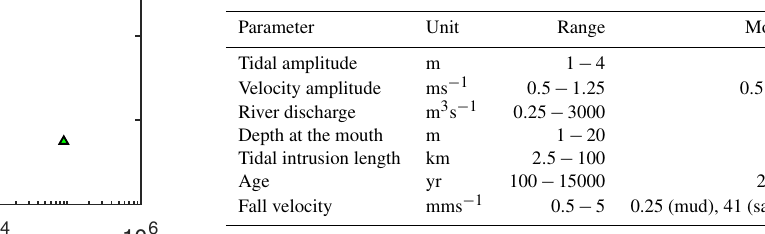
Table 4. Ranges of conditions in mixed estuaries at temperate zones (Prandle et al., 2005) compared to values for the modelling